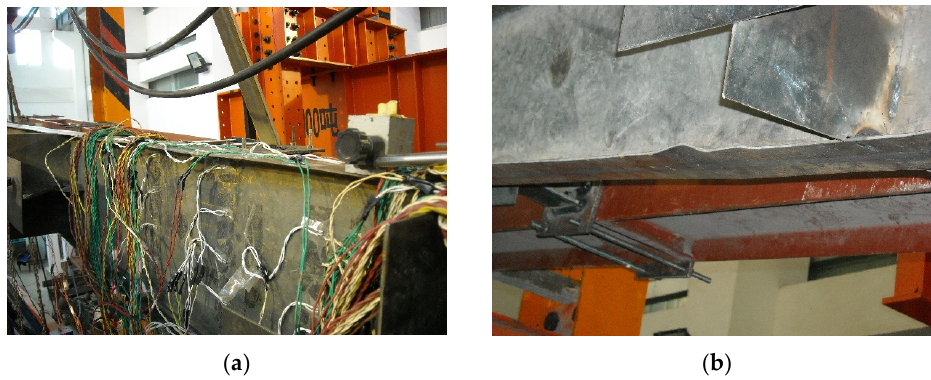
Figure 7. Failure phenomenon of specimen SV1. ( a ) Corrugation on the upper flange of the rafter; ( b ) Local buckling of the lower flange.